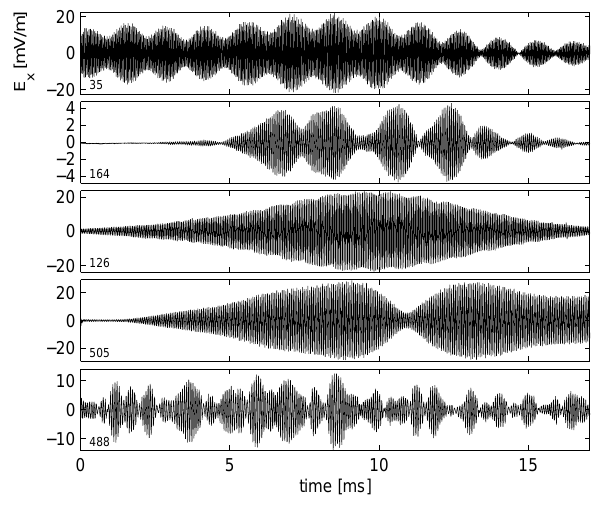
Fig. 1. Five typical coherent Langmuir wave packets observed by WIND. Only the E x electric field component is shown. The bot- tom plot shows a marginal case in which the wave-packet is barely